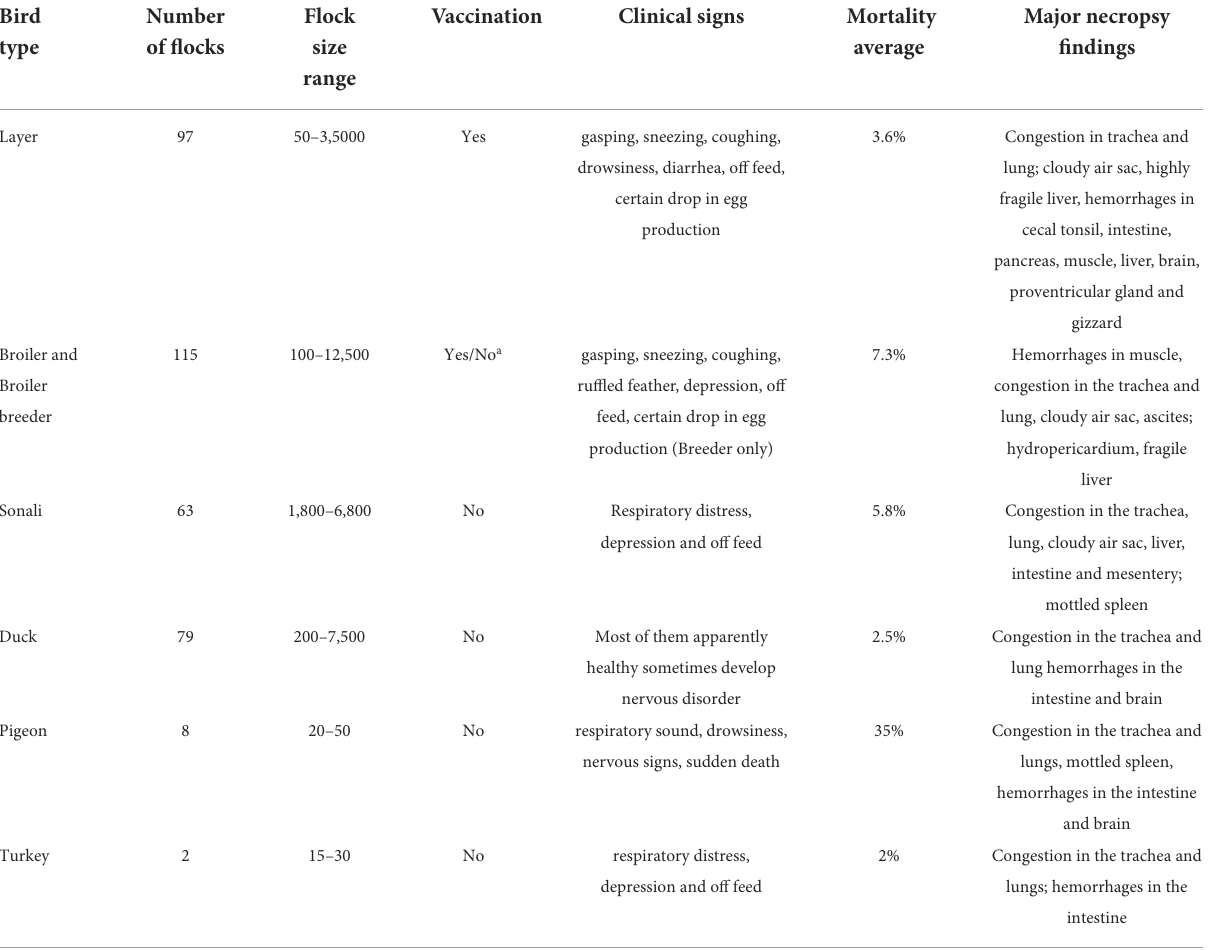
TABLE 1 Summary of respiratory outbreaks in poultry in Bangladesh in the current